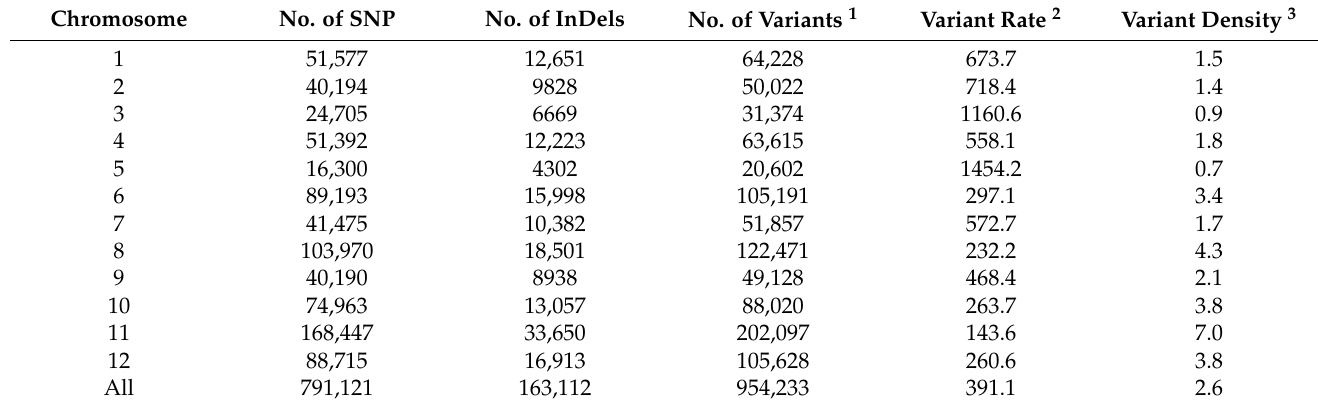
Table 1. Number of variants per chromosome.